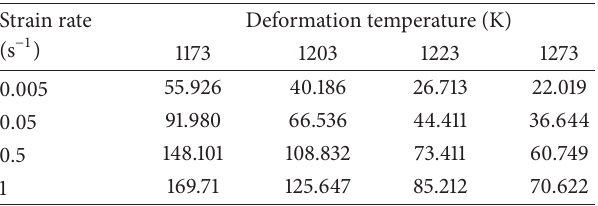
Table 2: Peak stress of TA15 stress-strain curves for different temperatures and strain rates.